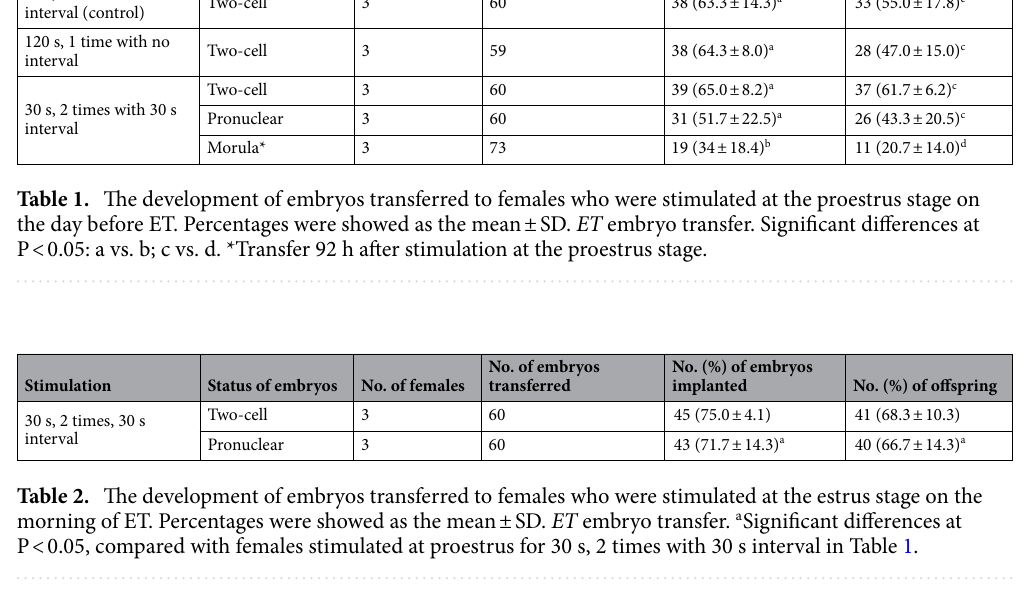
Table 2. The development of embryos transferred to females who were stimulated at the estrus stage on the morning of ET. Percentages were showed as the mean ± SD. ET embryo transfer. a Significant differences at P < 0.05, compared with females stimulated at proestrus for 30 s, 2 times with 30 s interval in Table 1.